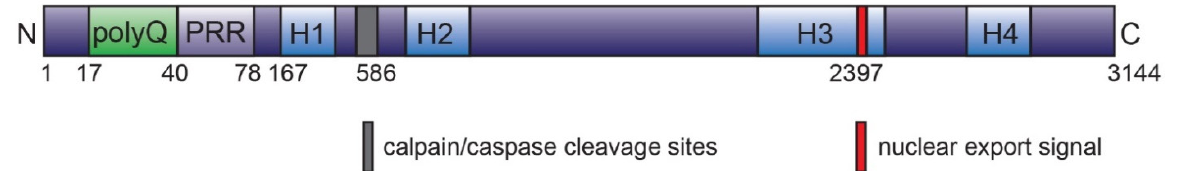
Figure 2. Overview of human huntingtin protein. Full-length HTT consists of 3144 amino acids, with a total molecular mass of 350 kDa. The N-terminal 17 amino acid region carries several post translational modification sites (such as acetylation, SUMOylation, phosphorylation, ubiquitination, etc.) and is followed by polyglutamine tract (polyQ; expanded in Huntington’s disease), proline rich region (PRR), HEAT repeat domains (H1-H4; the HEAT corresponds to proteins, where they were first described: huntingtin, elongation factor 3 [EF3], protein phosphatase 2A [PP2A], and the yeast kinase TOR). Leucine-rich nuclear export signal is located at the C-terminal region. The protein may undergo post translational modifications and/or protease cleavage on several sites, e.g., caspase-6 cleavage at aspartate 586 [50,72,75–77].